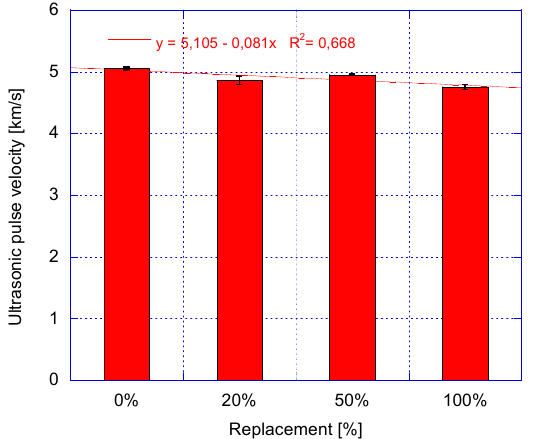
Figure 8. Ultrasonic pulse velocity at 28 days.